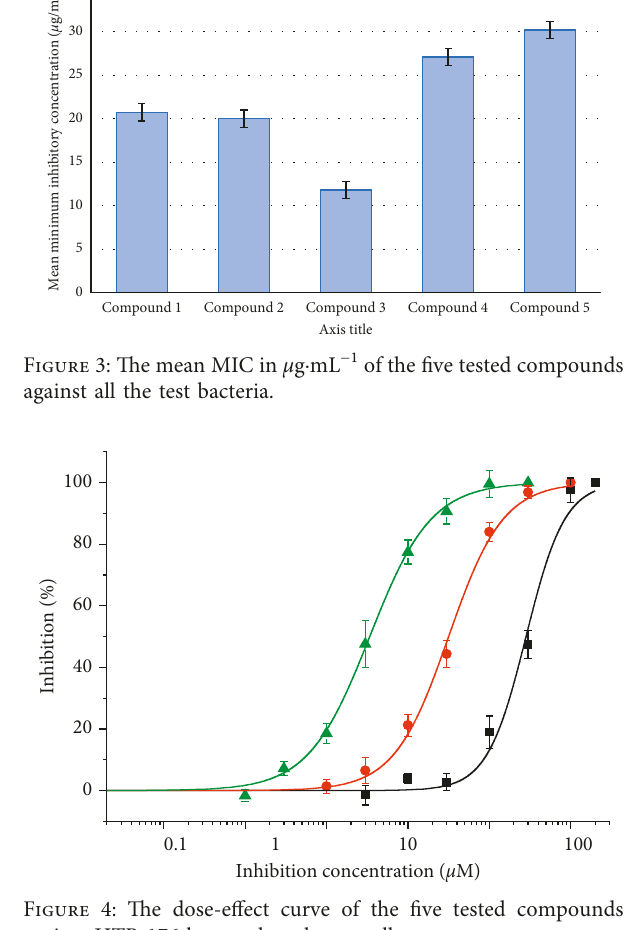
Figure 4: The dose-effect curve of the five tested compounds against HTB-176 human lymphoma